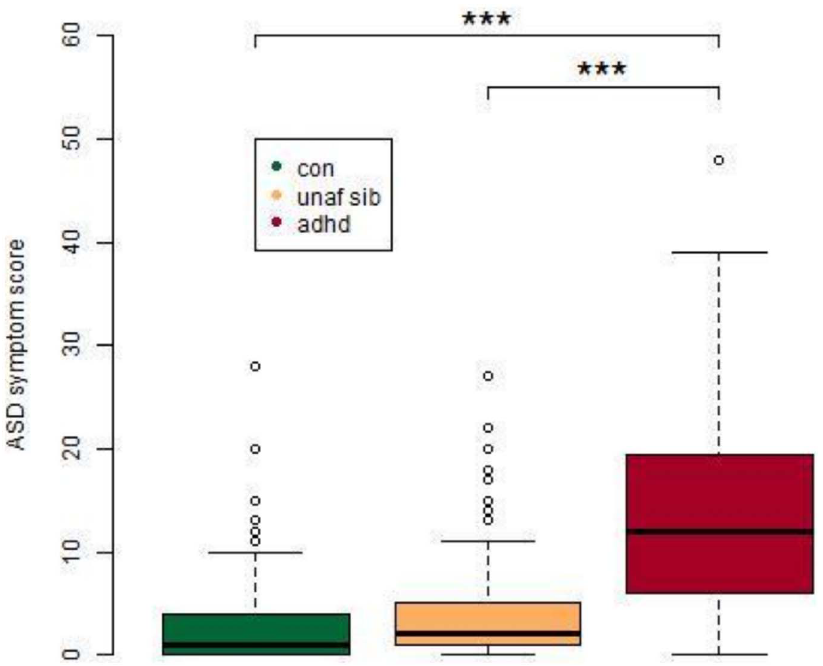
Figure 1. ASD symptoms in healthy controls, unaffected siblings and ADHD. ADHD subjects were found to have significantly higher scores relative to both unaffected siblings and healthy controls. ***p , 0.001, with post-hoc Tukey test, following an ANOVA. ASD symptom score refers to an aggregate score from the four Children’s Social and Behavioural Questionnaire (CSBQ) subscales, (1) social interest, (2) social understanding, (3) stereotypy and (4) resistance to change. Abbreviations: con, Control; unaf sib, Unaffected Siblings, adhd, Attention Deficit Hyperactivity Disorder.